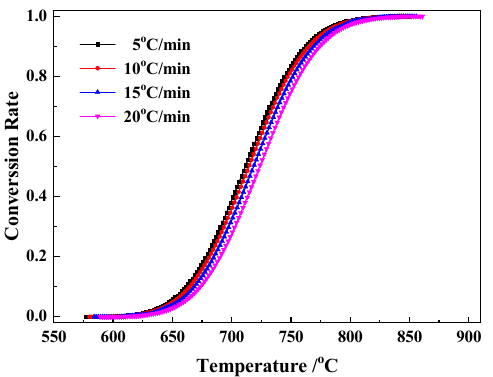
Figure 6. α –T curve of the decarburization reaction.